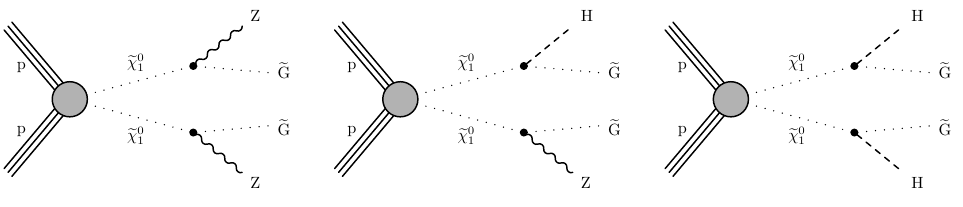
Figure 2 . A GMSB model